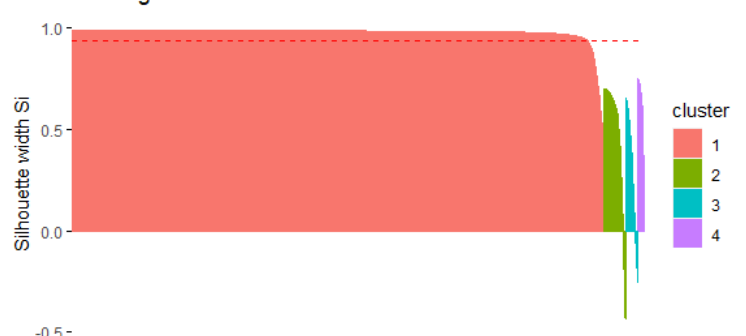
Figure 10. Silhouette after merging the